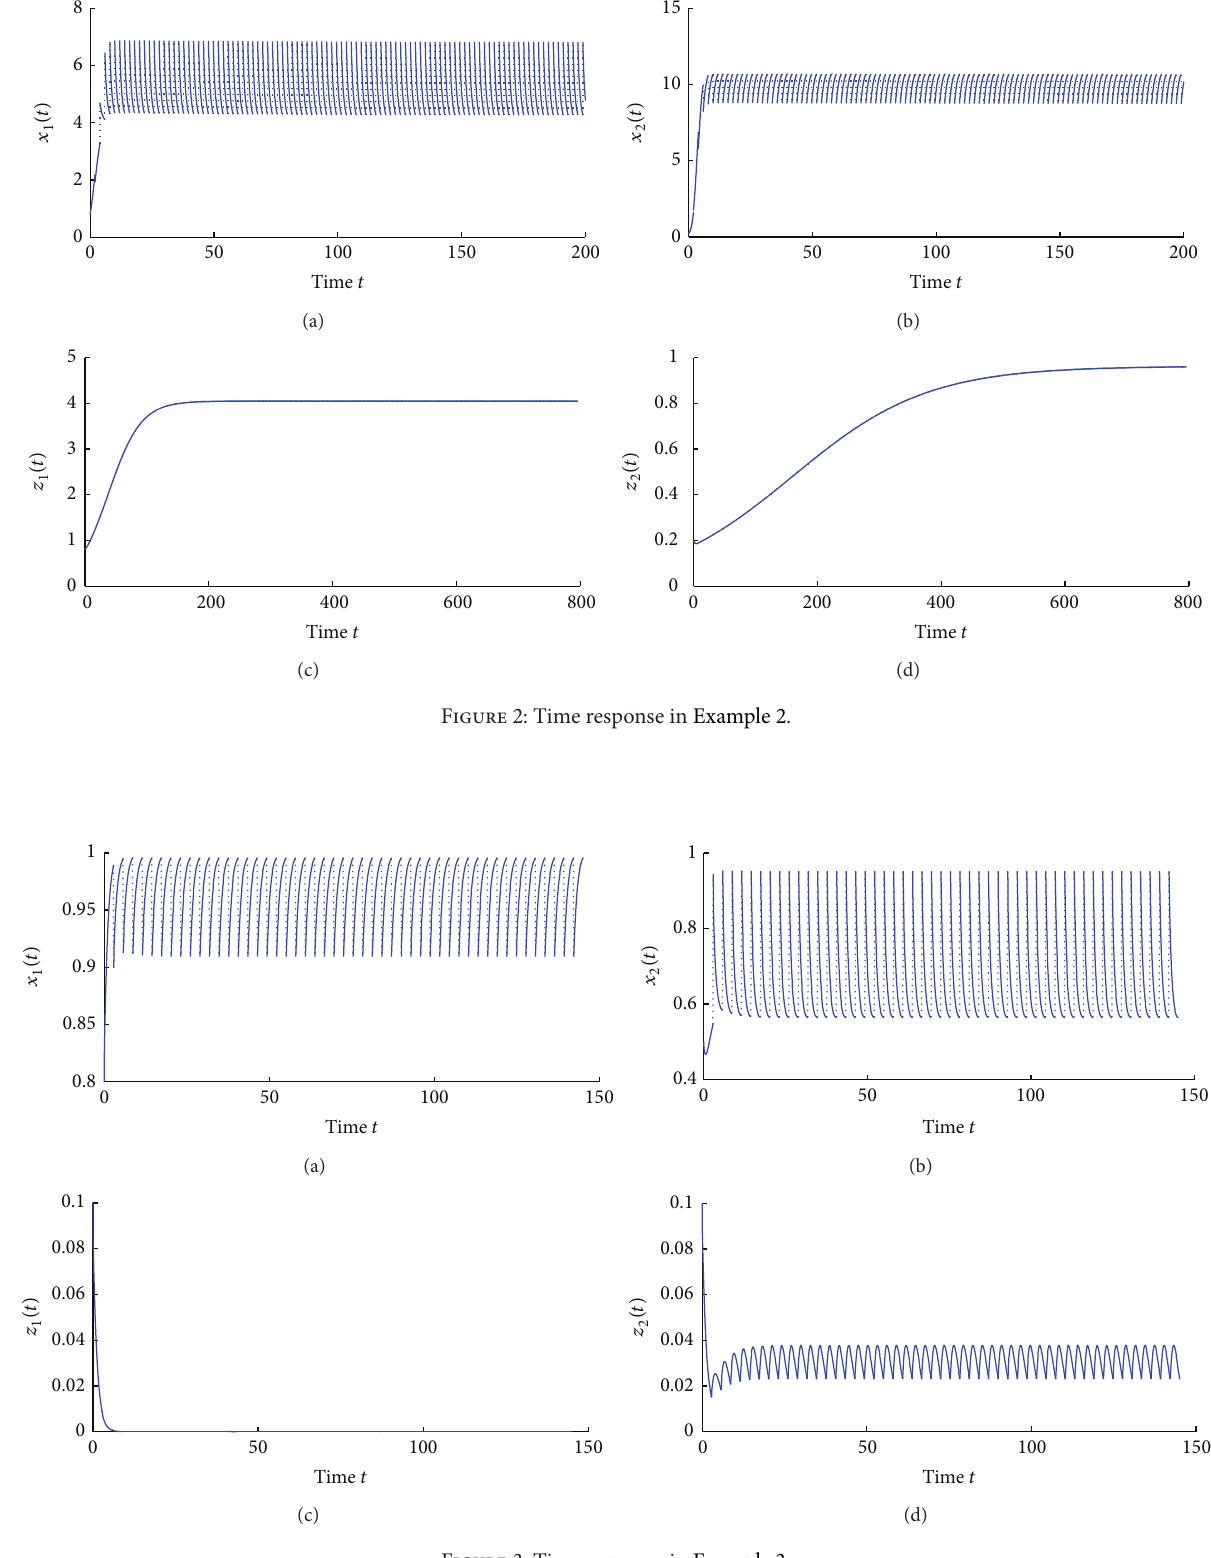
Figure 3: Time response in Example